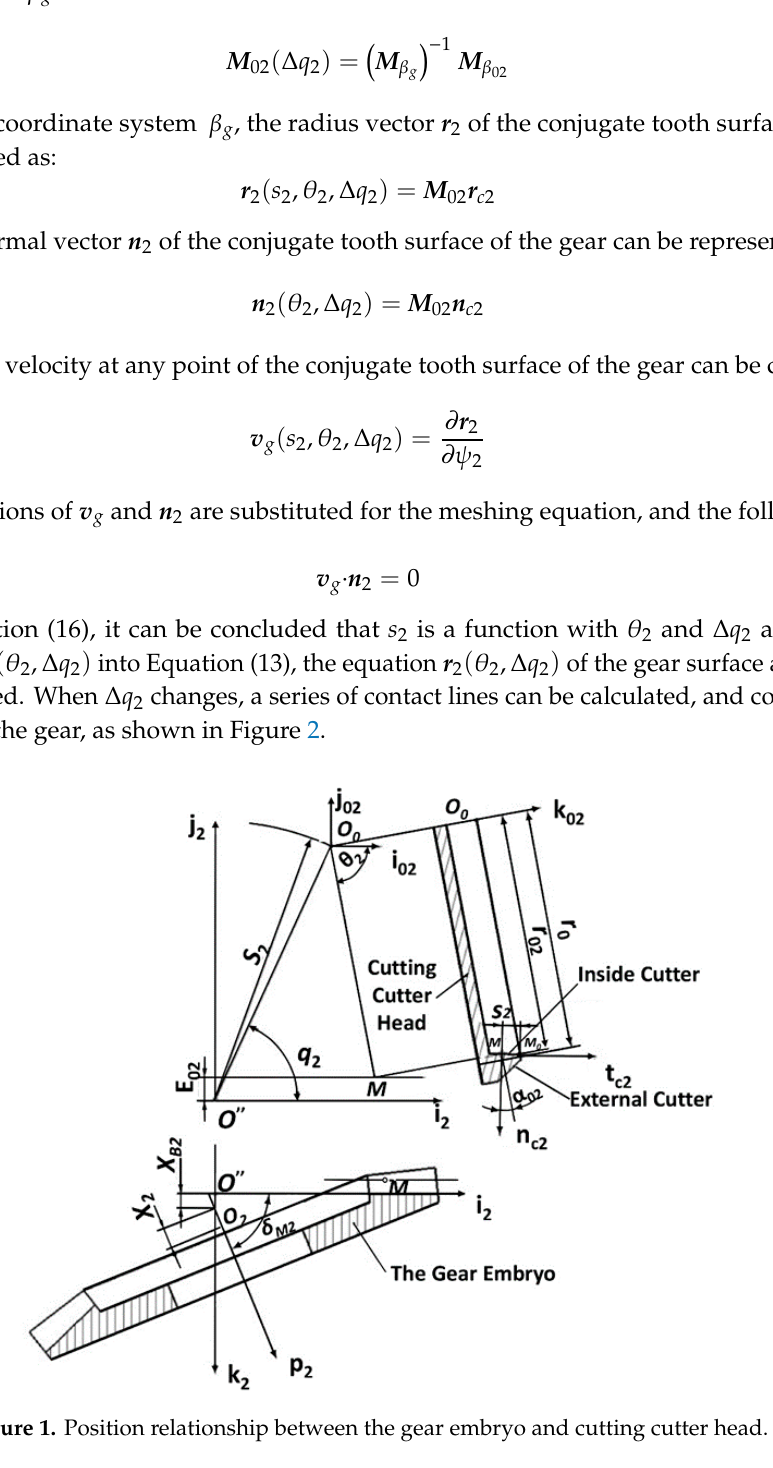
Figure 2. Theoretical Modeling of the gear concave and convex surfaces.